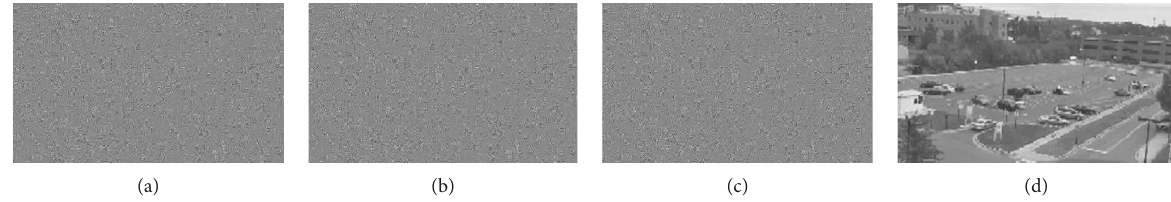
Figure 5: Sample results of decryption with incorrect keys (+ 10 15 ) . Modify the secret keys in α (a), x using the correct secret key (d).